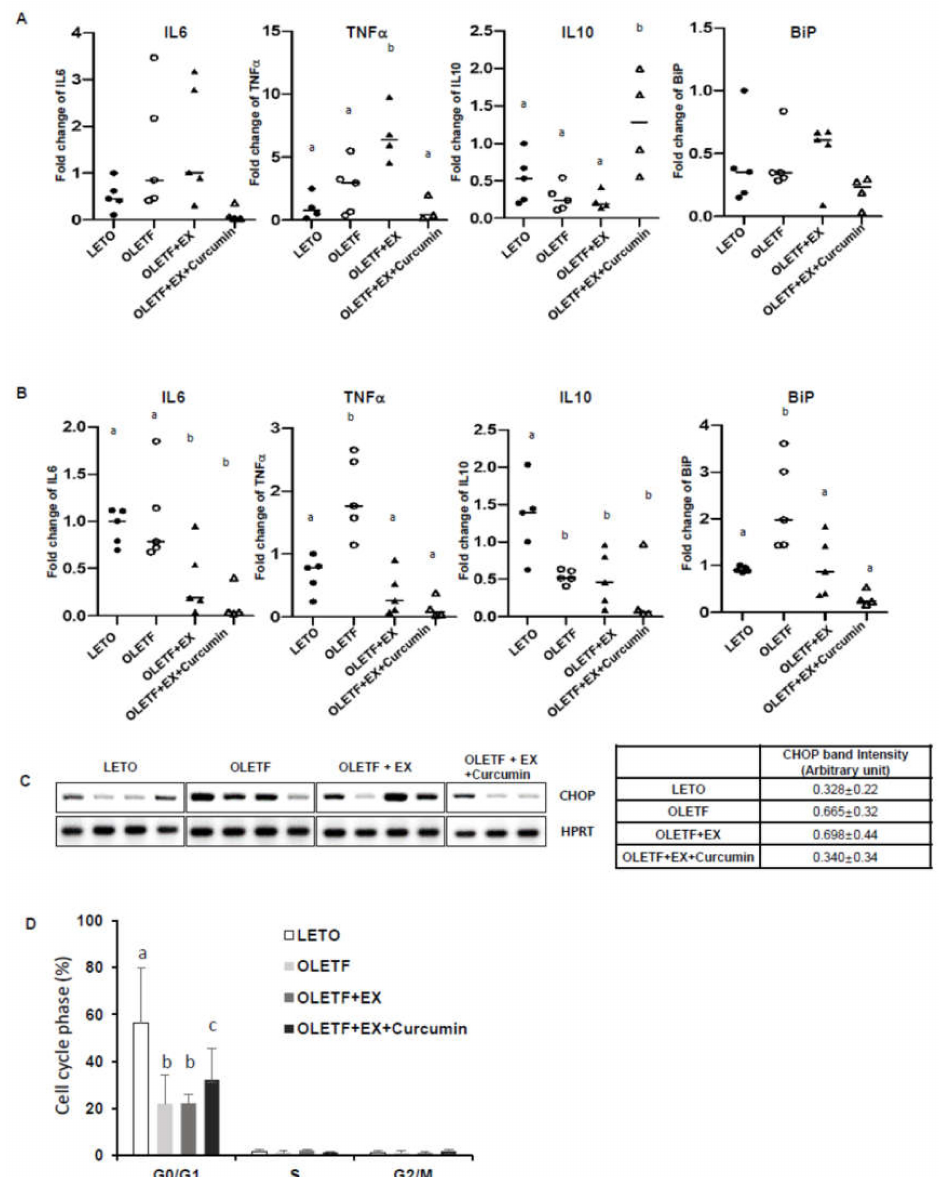
Figure 3. Curcumin supplementation with exercise inhibited proinflammatory cytokines and ER stress in small intestines. ( A – C ) The whole duoden ums ( A , C ) and jejunums ( B ) were harvested, RNAs were extracted, and cDNAs were synthesized for RT-PCR targeting apoptosis marker C / EBP homology protein (CHOP) ( C ) and for Real Time PCR targeting proinflammatory cytokines (IL6 and TNF α (pro-inflammatory cytokines), IL10 (anti-inflammatory cytokine)), and the ER stress marker BiP ( A , B ). Hypoxanthine phosphoribosyltransferase (HPRT) and β -actin were used as loading controls for RT-PCR and Real Time PCR, respectively. ( D ) In OLETF controls, curcumin plus exercise rescued the G0 / G1 phase of the cell cycle in isolated small intestine cells. Isolated small intestine cells were fixed with 70% ethanol and stained with Propidium Iodide (PI). Flow cytometry was used to quantify cell phases (%, of Y-axis). Significant di ff erences were determined using a one-way ANOVA followed by Turkey’s post-hoc test. Di ff erent superscripts indicate significant di ff erence ( p < 0.05). Results are presented as means ± standard errors. LETO controls: age-matched control group, OLETF controls: diabetic group, OLETF + EX group: diabetic exercise-trained group, OLETF + EX + Curcumin: diabetic exercise-trained group fed curcumin (5 g / kg in